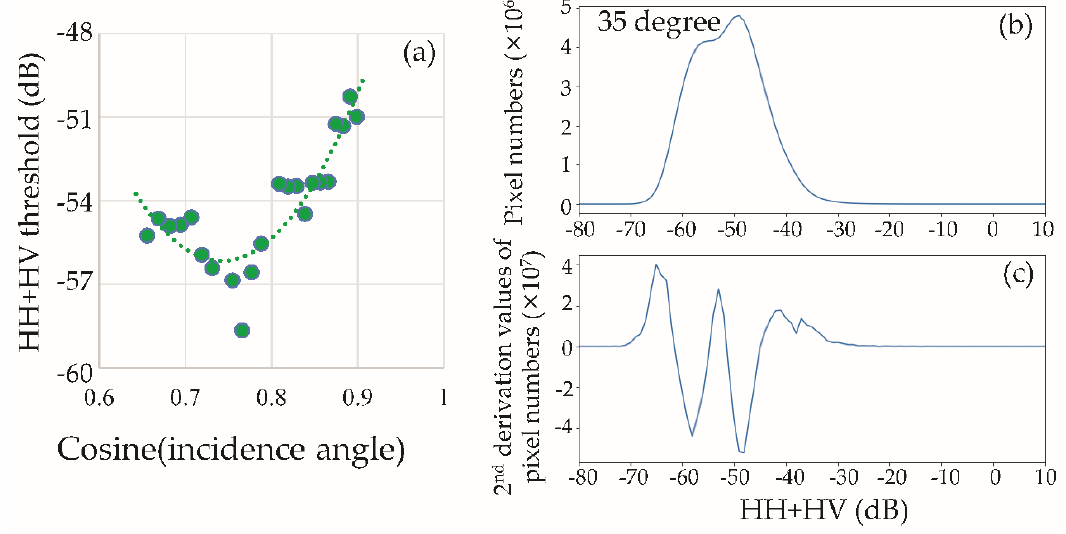
Figure 3. Scatter plot of the threshold A values from ALOS-2/PALSAR-2-ScanSAR data (sum of the backscattering coefficients of HH and HV microwave on a dB basis; hereafter, HH σ 0 + HV σ 0 , n = 22) ( a ), which is one of three thresholds (A–C) discriminating the inundated paddy soils and noninundated paddy soils in the Mekong Delta, and a sample of the histograms of the HH σ 0 + HV σ 0 values of pixels ( b ), and its second derivative values ( c ). Each threshold A value was obtained from every local incidence angle from 26 to 49 degrees, except for 2 plots from the 37 and 42 incidence degrees, where the thresholds were not clearly detected. The values illustrated in subfigures ( b , c ) were obtained based on all the pixels with the 35 degree local incidence angle. The horizontal axis of subfigure ( a ) indicates the cosine values of every local incidence angle. The horizontal axis of the subfigures (b,c) indicates the values of HH σ 0 + HV σ 0 .